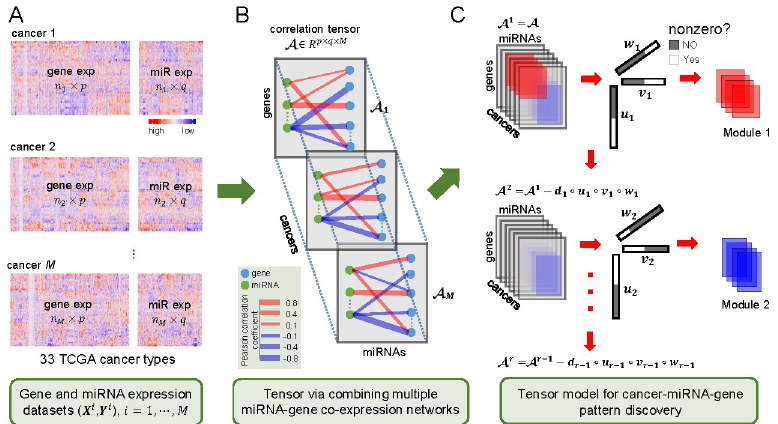
Fig 1. Illustration of TSCCA to identify cancer-related miRNA-gene functional modules. (A) Prepare the matched miRNA and gene expression data of 33 cancer types from TCGA. (B) Compute a cancer-miRNA-gene Pearson correlation tensor A 2 R p � q � M , where p , q and M represent the number of genes, miRNAs and cancers respectively. (C) Estimate multiple sparse latent factors ( u i , v i and w i , i = 1, ��� , r ) and these non-zero genes in u i , non-zero miRNAs in v and non-zero cancers in w are considered as a cancer-miRNA-gene i i